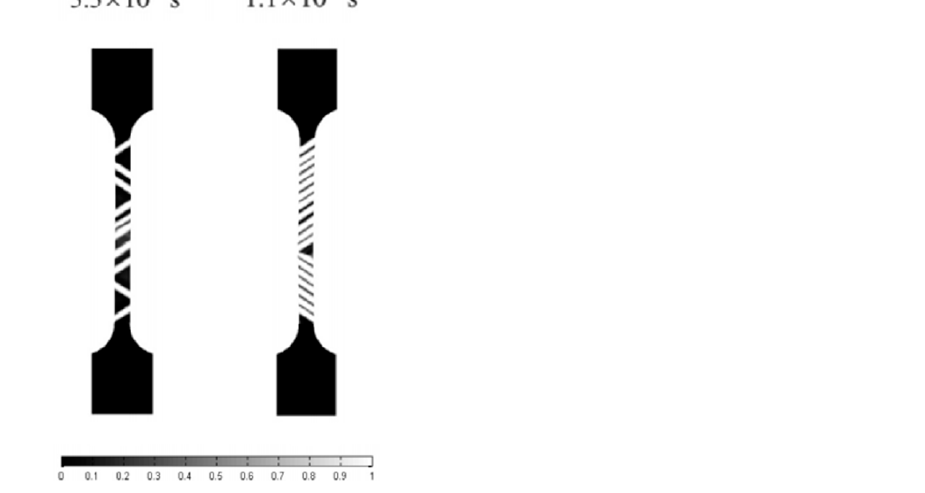
Figure 15. Phase evolution contours under 3.3 × 10 − 2 s − 1 and 1.1 × 10 − 1 s − 1 [100]. (Adapted from Ref. [100], Fig. 20, 2015, with permission from Elsevier.)